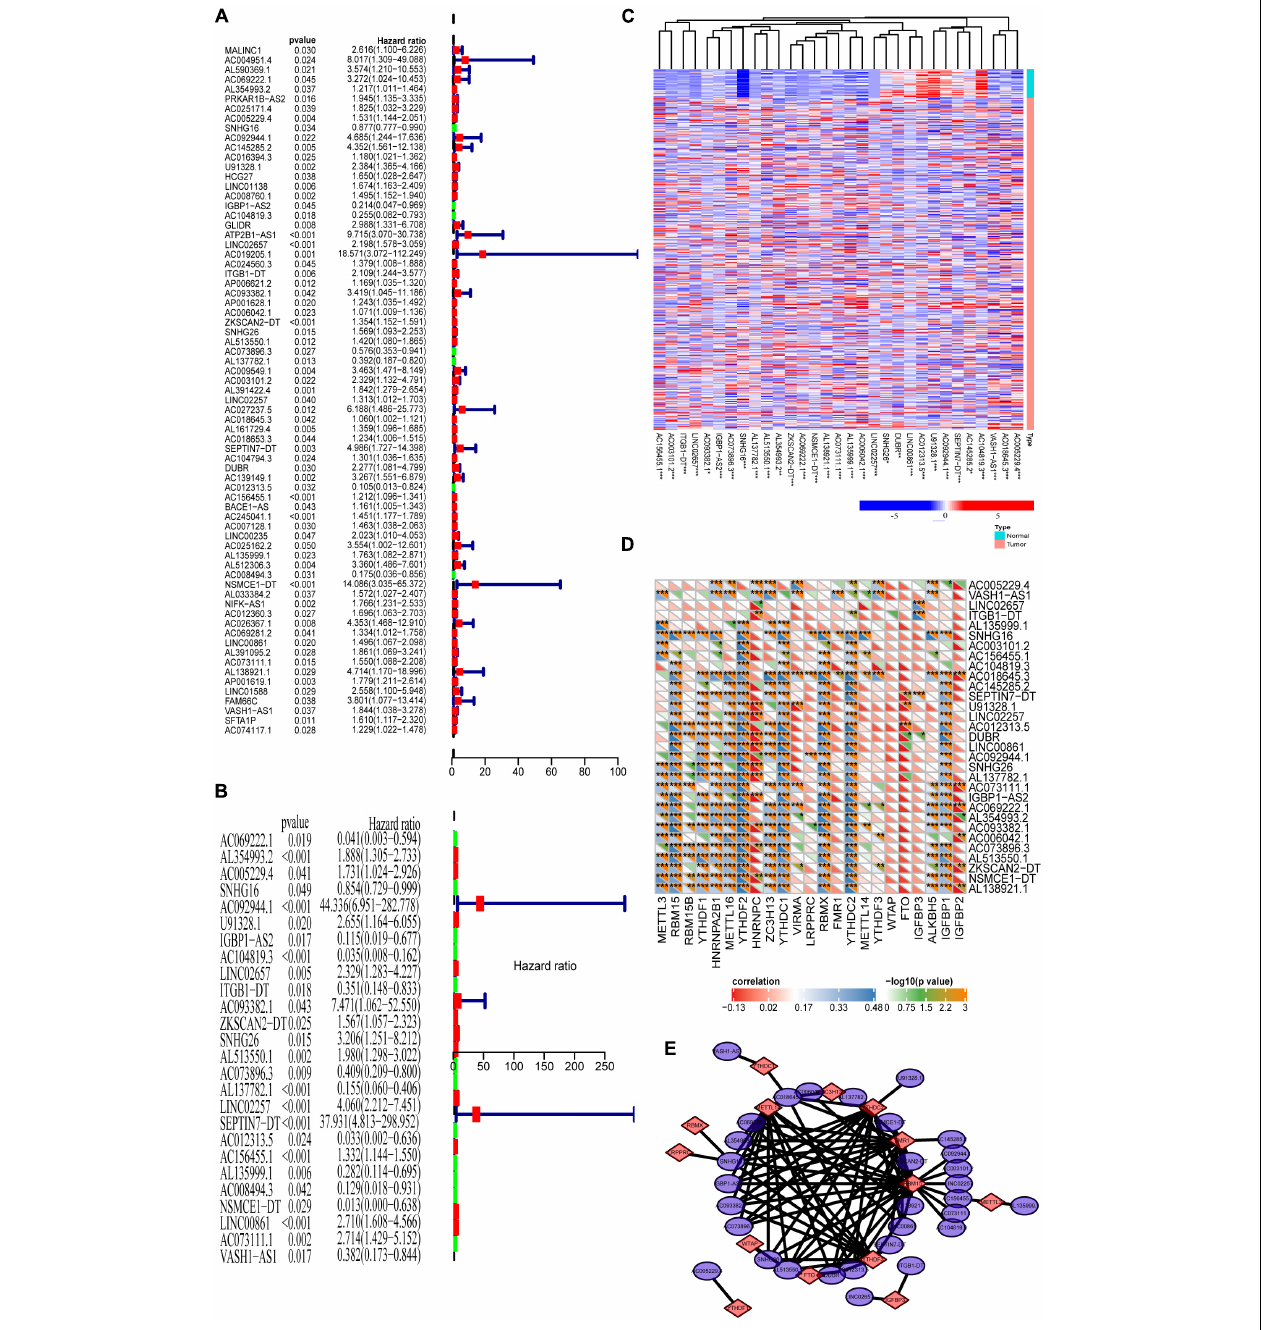
FIGURE 3 | Prognosis analysis of the m6A-lncRNAs. (A,B) Univariate and multivariate analyses reveal the prognostic ability of the m6A-related lncRNAs. (C) Heat map showing the expression levels of 31 prognostic m6A-related lncRNAs in the TCGA-COAD cohort (Wilcoxon test). (D) Heat map of the correlations between m6A-related genes and the 31 prognostic m6A-related lncRNAs. (E) The regulatory network between m6A methylated genes and 31 lncRNAs with prognostic